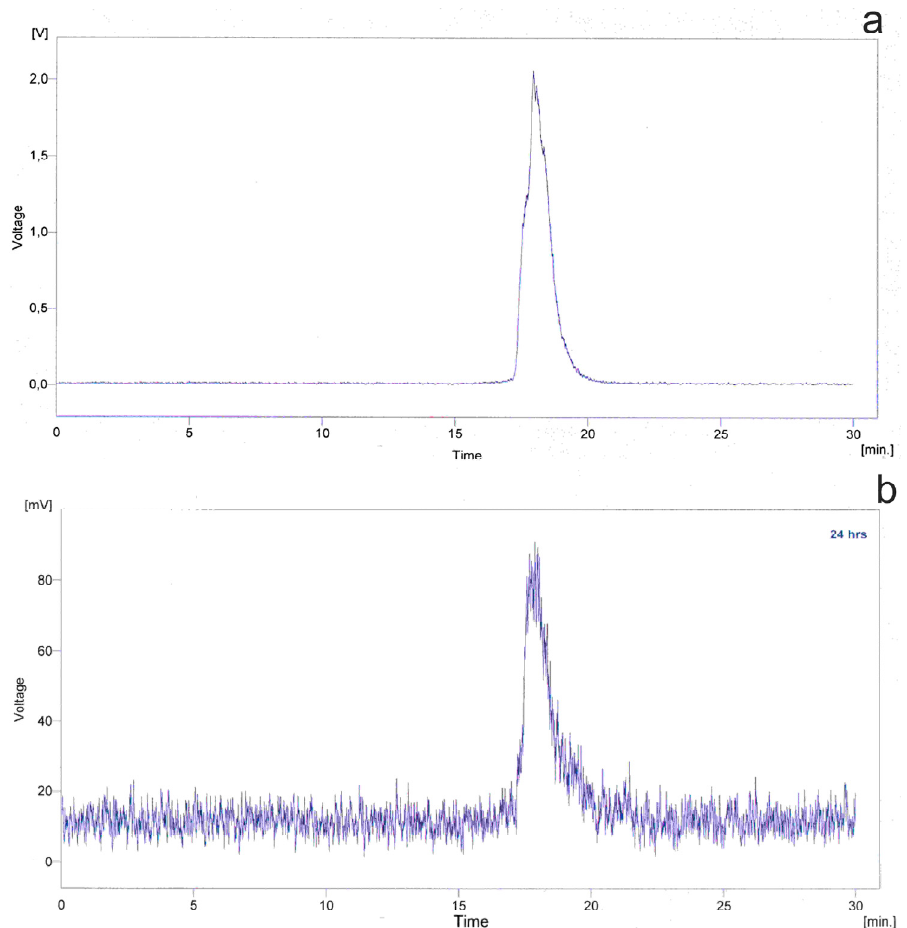
Figure 4. Radiochromatograms of complexes formed by technetium-99m with tricine